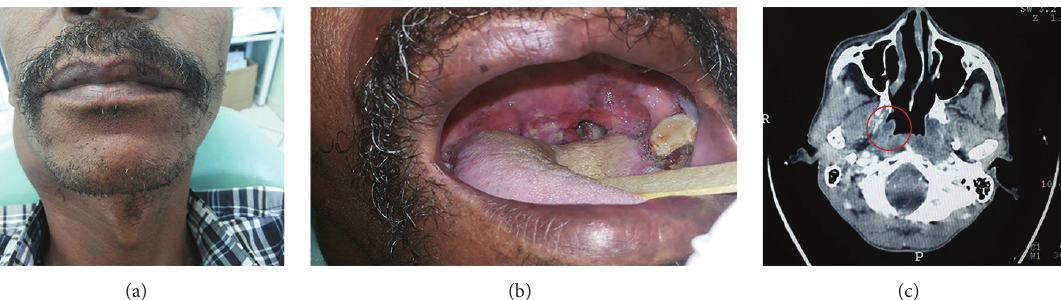
Figure 1: (a) The swelling on the right side of the neck, (b) ulcerated mass on the right palatine tonsil, and (c) CT image exhibiting a lobulated and ill-defined lesion (red circle).